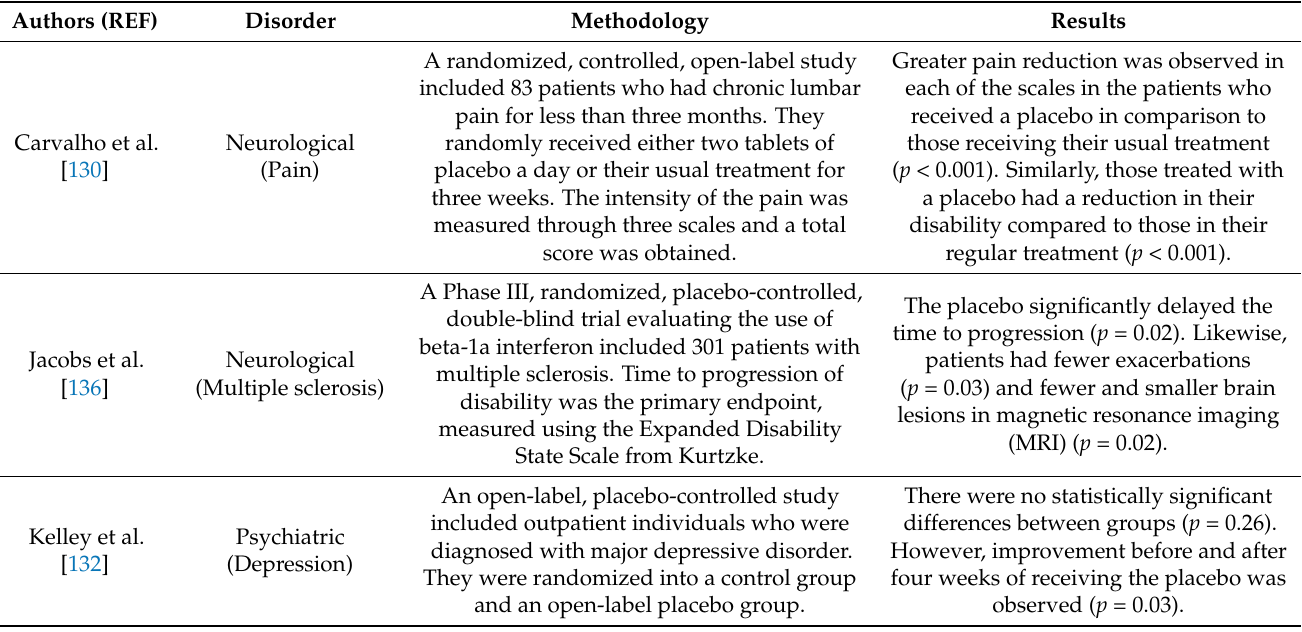
Table 2. Clinical evidence of the placebo